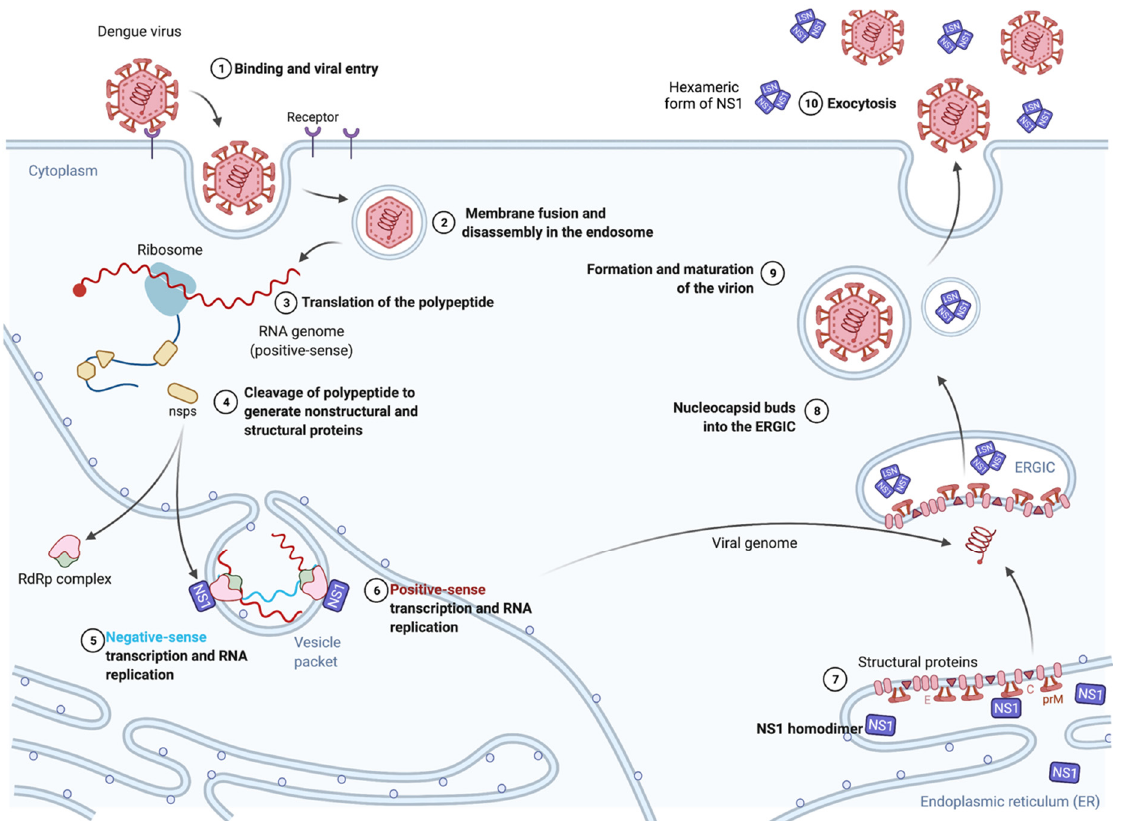
Figure 1. DENV NS1 protein involvement in the viral cycle. Nonstructural protein 1 (NS1) of flaviviruses has been described with diverse functions during the viral lifecycle (1–10). After its cleavage from the polyprotein (3,4), NS1 forms homodimers associated with viral RNA complexes (5,6) and contributes to viral morphogenesis through interactions with the prM and E proteins (7,8). Furthermore, thanks to its hydrophobic properties and membrane affinity, NS1 participates in the formation of vesicle packets, which are essential structures hosting viral replication machinery. Interestingly, among the nonstructural proteins, NS1 has a particular fate. Indeed, the soluble hexameric form of NS1 circulates in infected individuals. The release of soluble NS1 requires protein transport into the ERGIC (ER–Golgi intermediate compartment) (10).